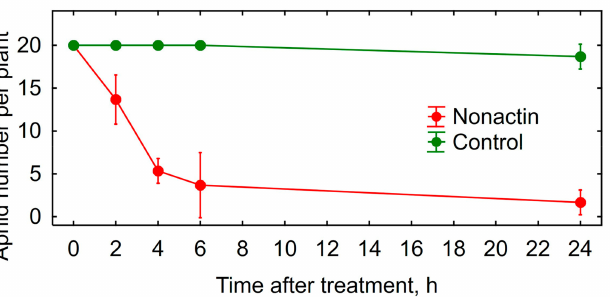
Figure 5. Toxicity of nonactin against vetch aphid in greenhouse experiment with bell pepper in vivo. Vertical bars show confidence intervals ( p = 0.05, n = 4).